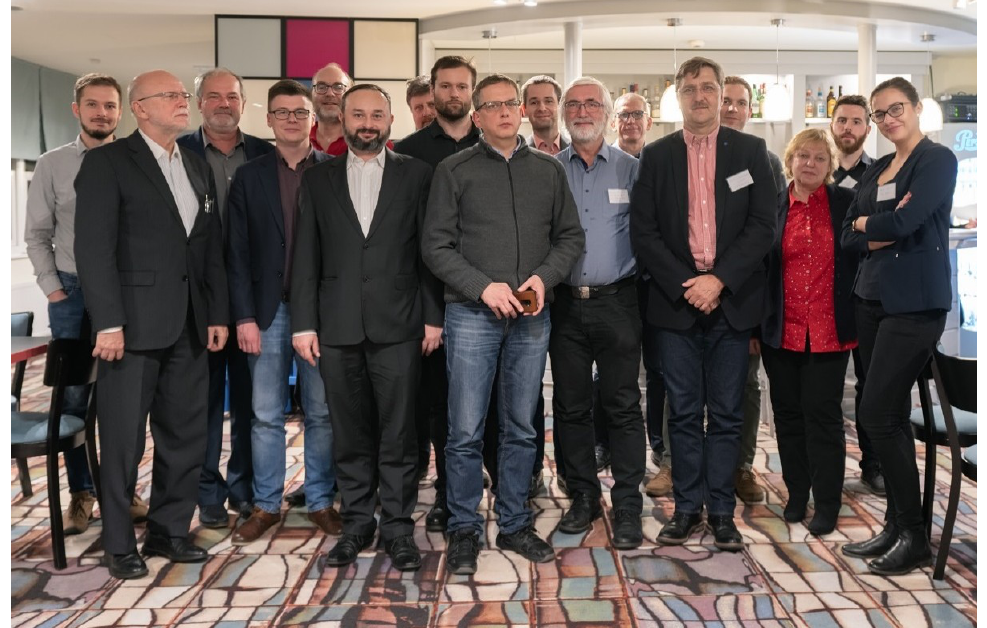
Figure 20. Wrocław workshop participants (from left to right): Stefan Schlaffer, Zbigniew W. Kundzewicz, Włodzimierz Marszelewski, Marcin Nowak, Karl-Erich Lindenschmidt, Stefan Iwicki, Adam Łazarów, Michał Kubicki, Bogusław Pawłowski, Tomasz Niedzielski, Bernd Hentschel,